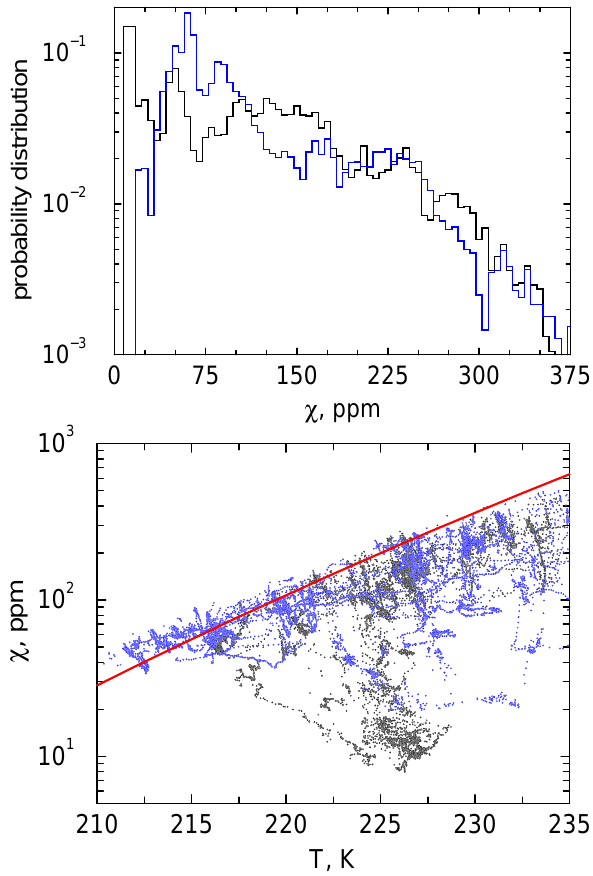
Fig. 6. Top panel: Probability distributions of χ measured dur- ing the INCA experiment (Prestwick, black curves; Punta Arenas, blue curves). The stair steps represent the discretized in situ data. Bottom panel: Scatter plot of water vapor mixing ratios and tem- peratures observed during INCA using the same color coding. The red curve marks the frost point H 2 O mixing ratios, evaluated for a constant pressure of 250